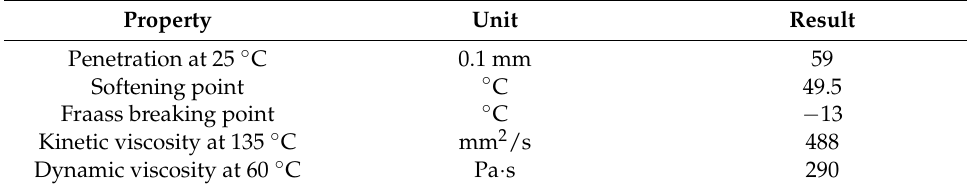
Table 5. Properties of 50/70 paving grade bitumen.